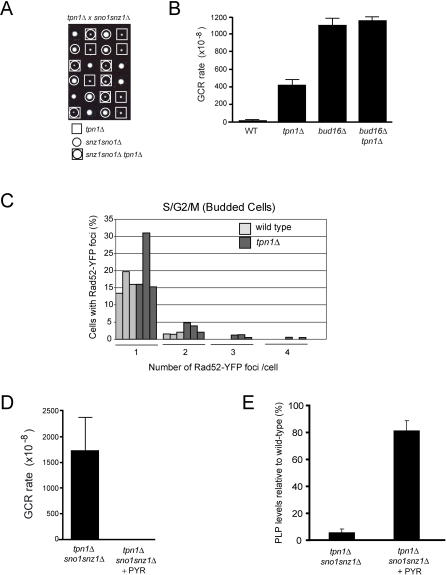
PLP Levels Correlate with Genome Stability(A) Tetrad analysis of tpn1Δ (square) crossed to sno1snz1Δ (circle). Viable triple mutant tpn1Δ sno1snz1Δ can be recovered (circle in square).(B) GCR rates at ChrXV-L of the indicated strains.(C) Quantitation of Rad52-YFP foci per cell in wild-type and tpn1Δ cells.(D) GCR rates at ChrXV-L of tpn1Δ sno1snz1Δ triple mutant grown with pyridoxine (+PYR) or without added pyridoxine to the media.(E) Relative PLP levels of the tpn1Δ sno1snz1Δ triple mutant grown with pyridoxine (+PYR) or without added pyridoxine to the media.